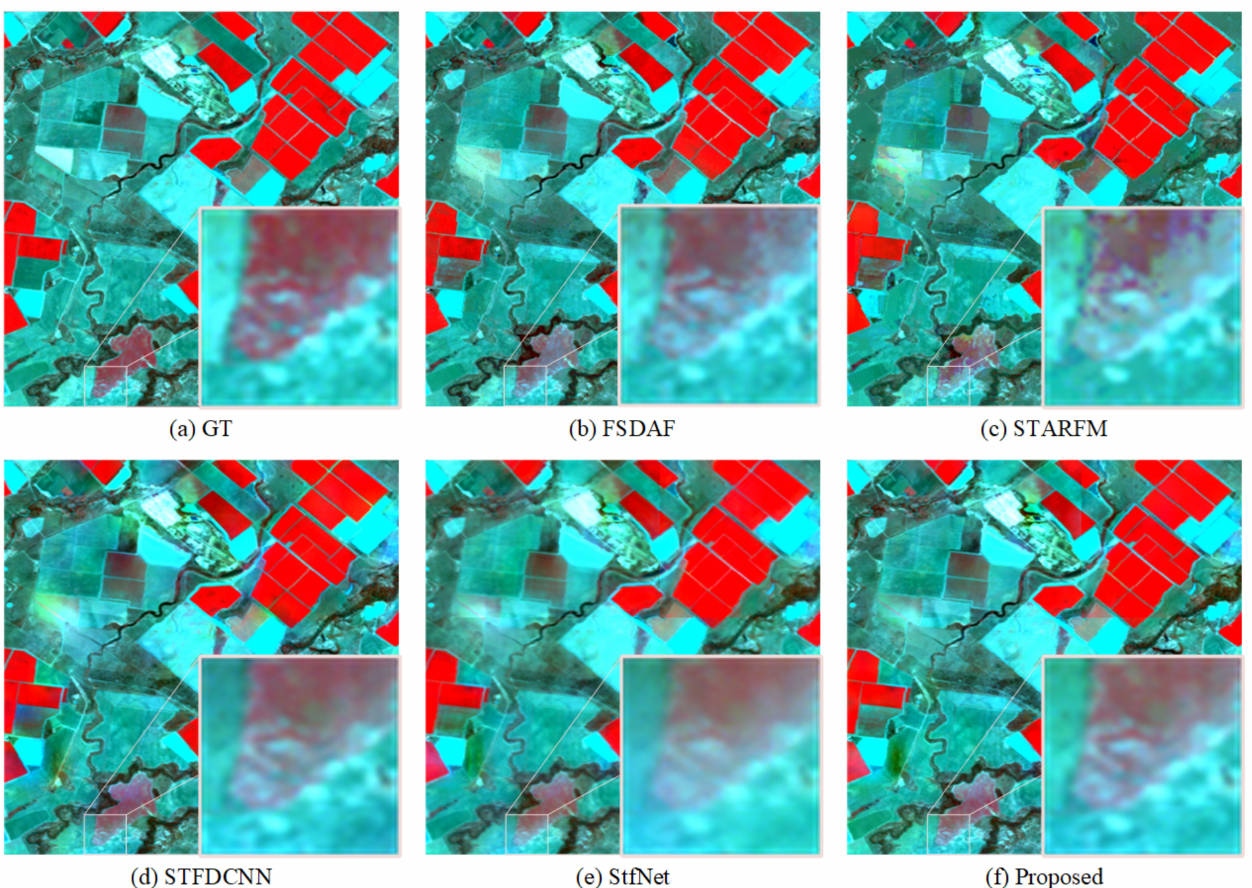
Figure 11. Insufficient prediction results for the target Landsat image (14 February 2005) in the LGC [31] dataset. Addi- tionally, comparison methods include FSDAF [13], STARFM [8], STFDCNN [18], and StfNet [19], which are represented by ( b – e ) in the figure respectively. In addition, ( a ) represents the ground truth (GT) we got, and ( f ) represents the method we